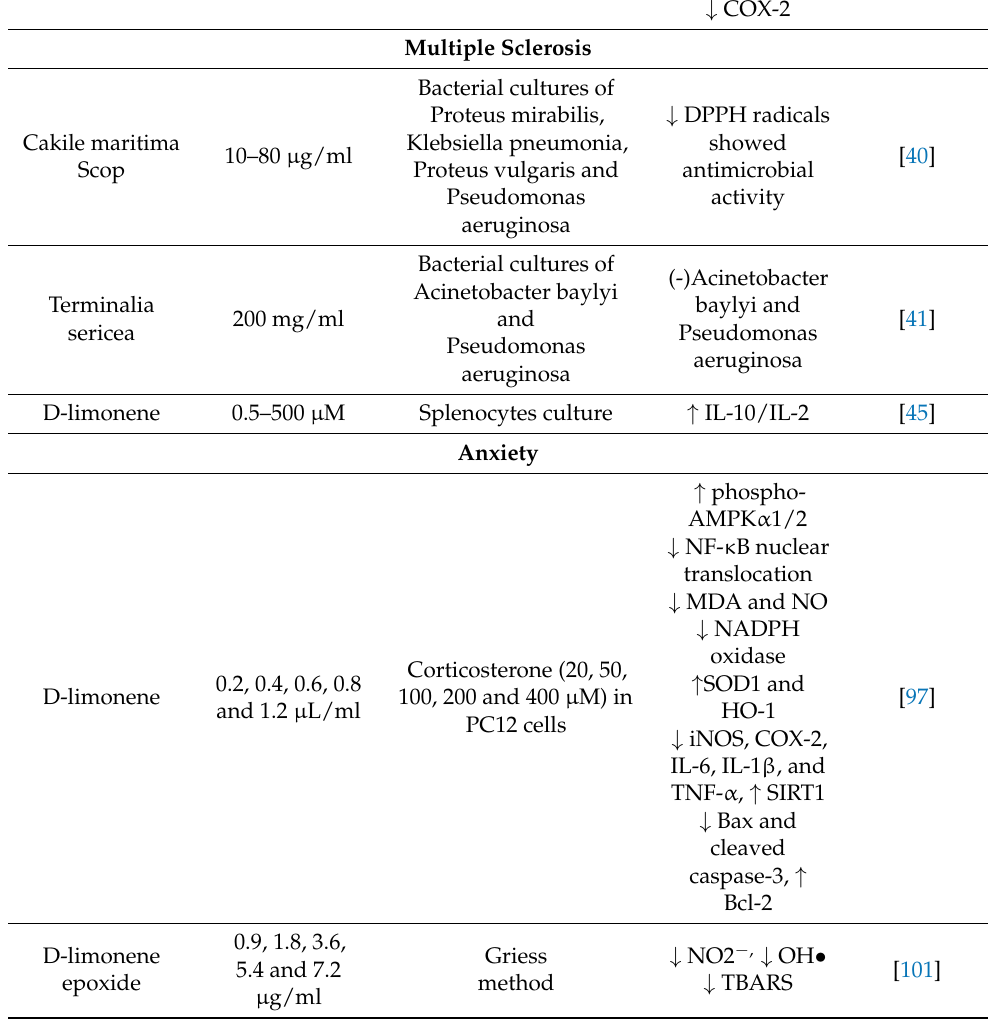
Table 2. The in vitro studies demonstrating the neuroprotective actions and mechanisms of limonene.